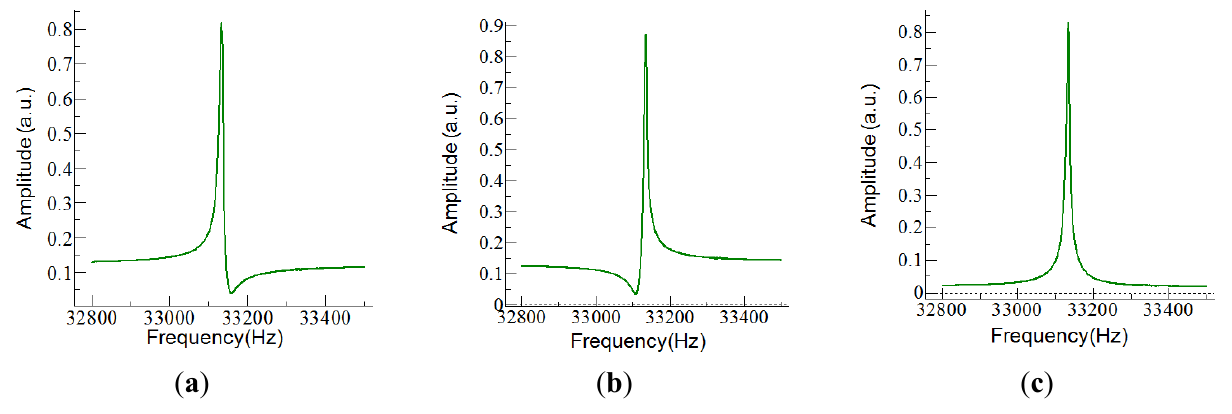
Figure 5. Different situations when compensating the parasitic capacitor with the developed circuitry: undercompensated ( a ), overcompensated ( b ), and adjusted ( c